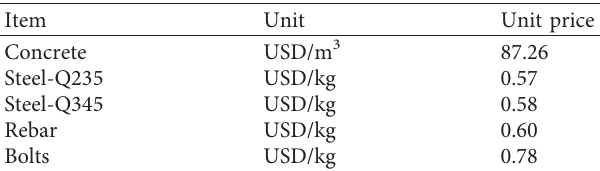
Table 7: Unit cost of resources.